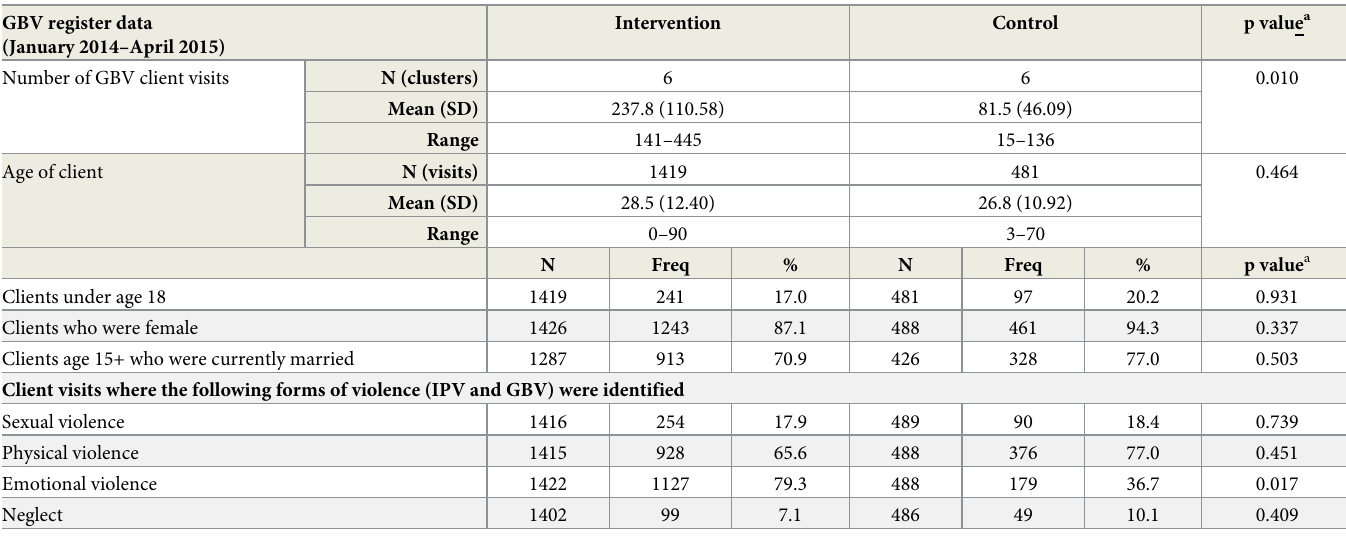
Table 10. Characteristics of GBV clients at study health